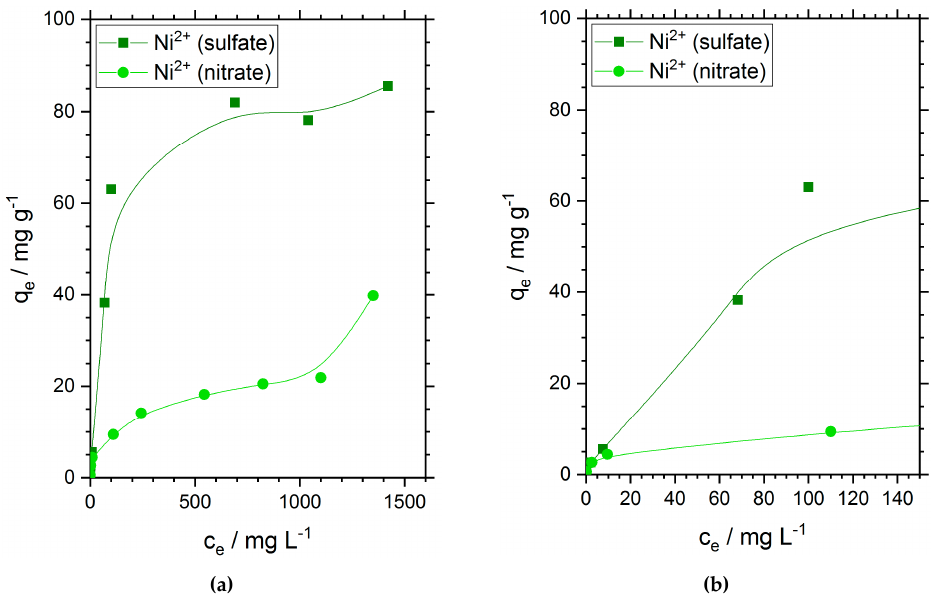
Figure 2. Adsorption isotherms of nickel at 25 ◦ C. ( a ) displays the full measurement and indicates the adsorption equilibrium in dependence of the concentration; ( b ) shows a close up of ( a ) for very low concentrations. Initial pH-values range from 5.8 to 6.3.